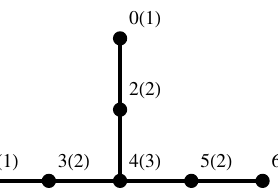
Figure 11 . Oriented b E 6 quiver with a particular labelling of the nodes i . The numbers in the parentheses represent the Coxeter labels d i .